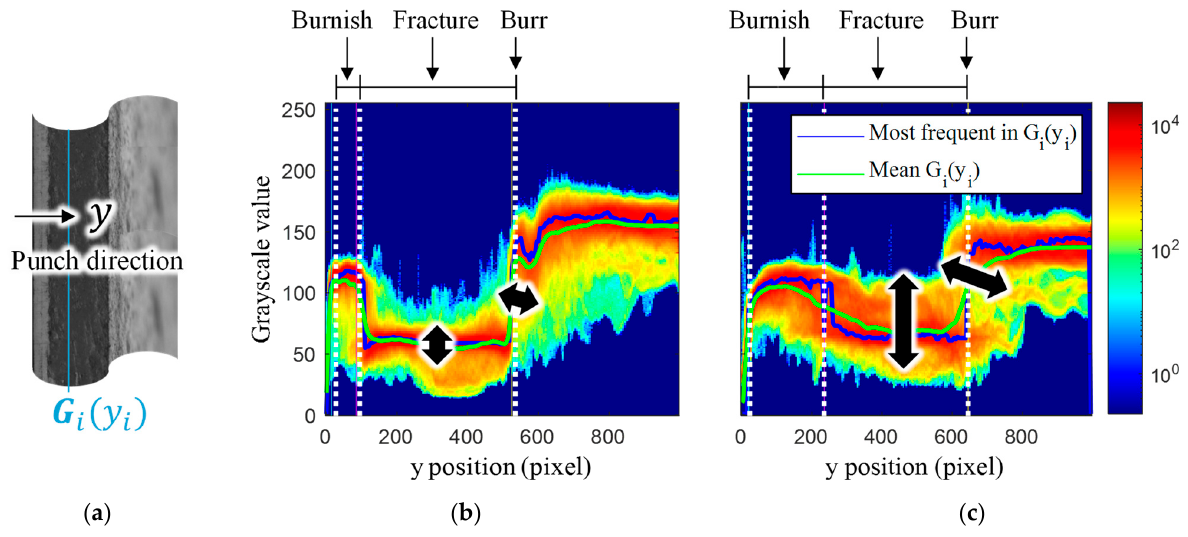
which is 𝑤 (cid:3400) 5 matrix where 𝑤 is width of the panorama image. Subsequently, the sta- tistical features of 𝑆 (cid:3029) were calculated to yield a feature vector of length 25.